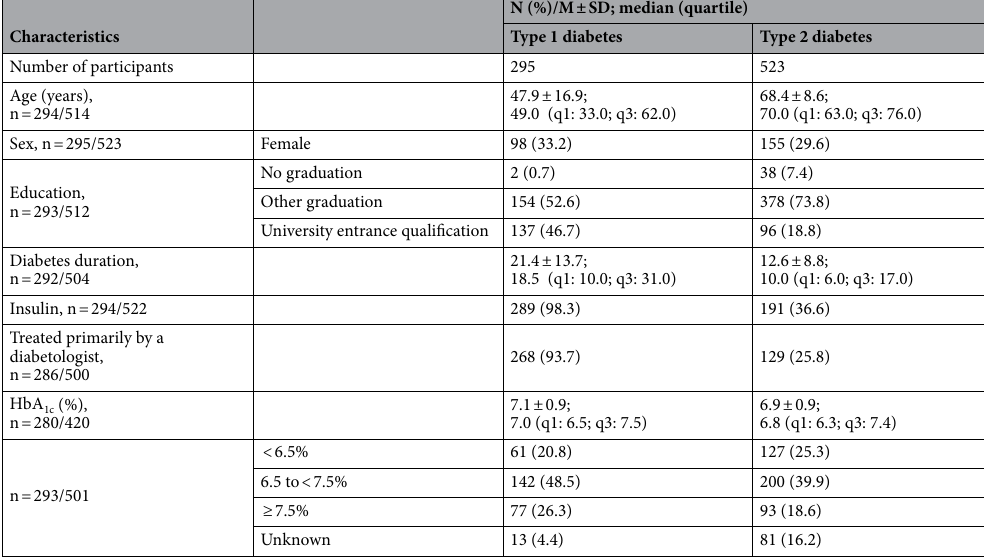
Table 1. Participants’ characteristics. M = mean, SD = standard deviation, HbA 1c = hemoglobin